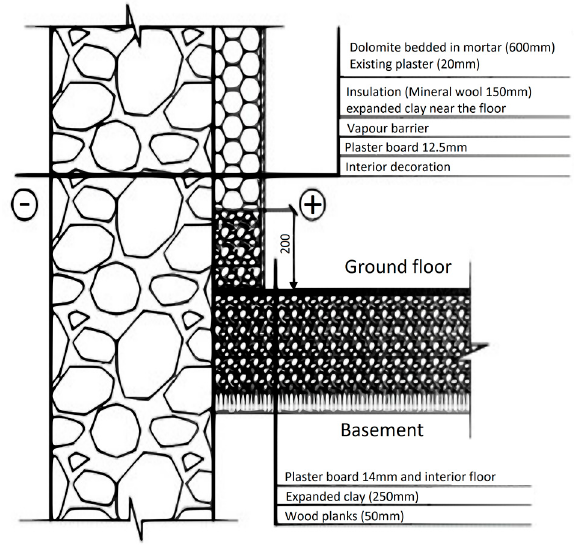
Figure 4. The cross-section of the living room’s wall and floor construction after renovation in 2015. After the renovation in 2015, external walls were divided into four types (see Figure